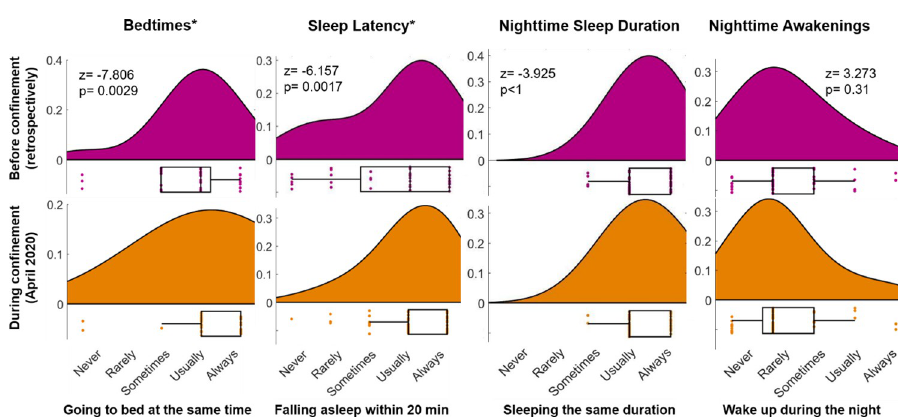
Fig 4. Acute changes in sleep behaviors in preschool children during the COVID-19 confinement. In pink, distribution of sleep behaviors is presented for pre-CONFINEMENT, orange refers to sleep during-CONFINEMENT. Dots represent values of individual subjects. Significance level based on a Wilcoxon signed-rank test is indicated as � p < 0.01.